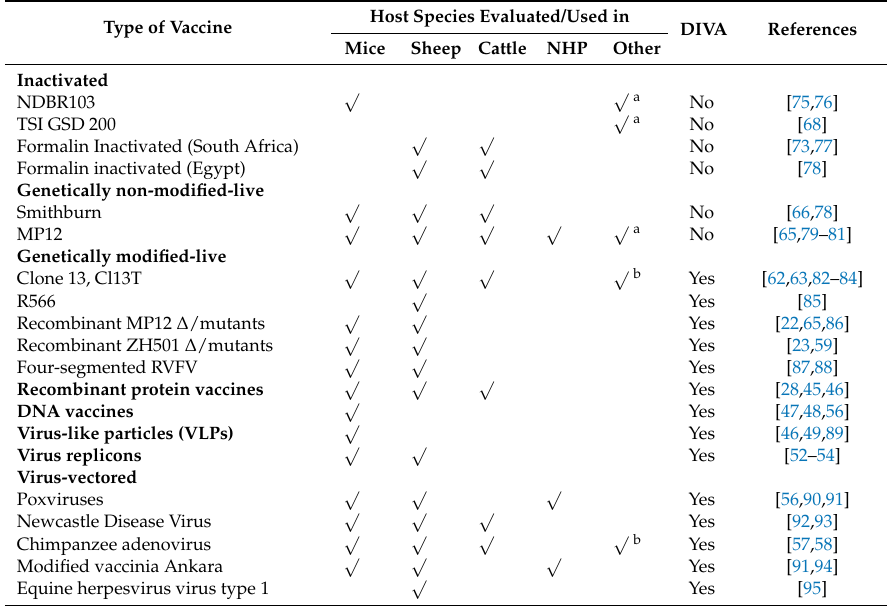
Table 1. Status of RVF vaccines and vaccine candidates evaluated for efficacy in different animal